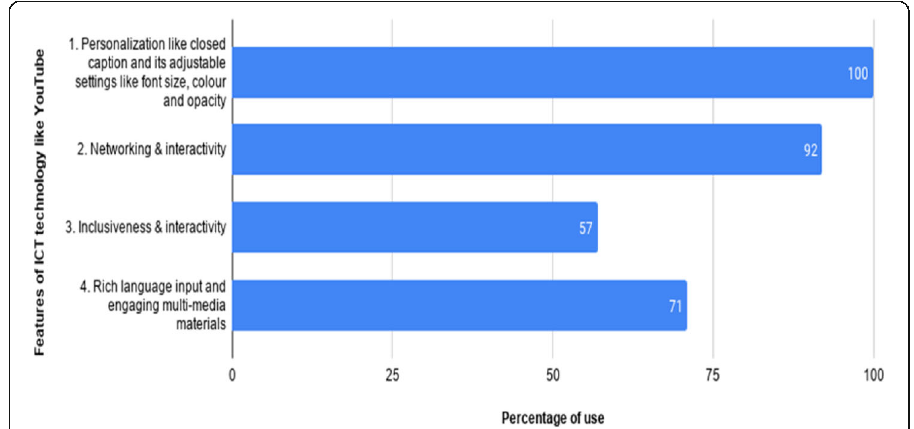
Fig. 2 Features of ICT technology like YouTube Vs. Percentage of active use by this group of learners while learning English